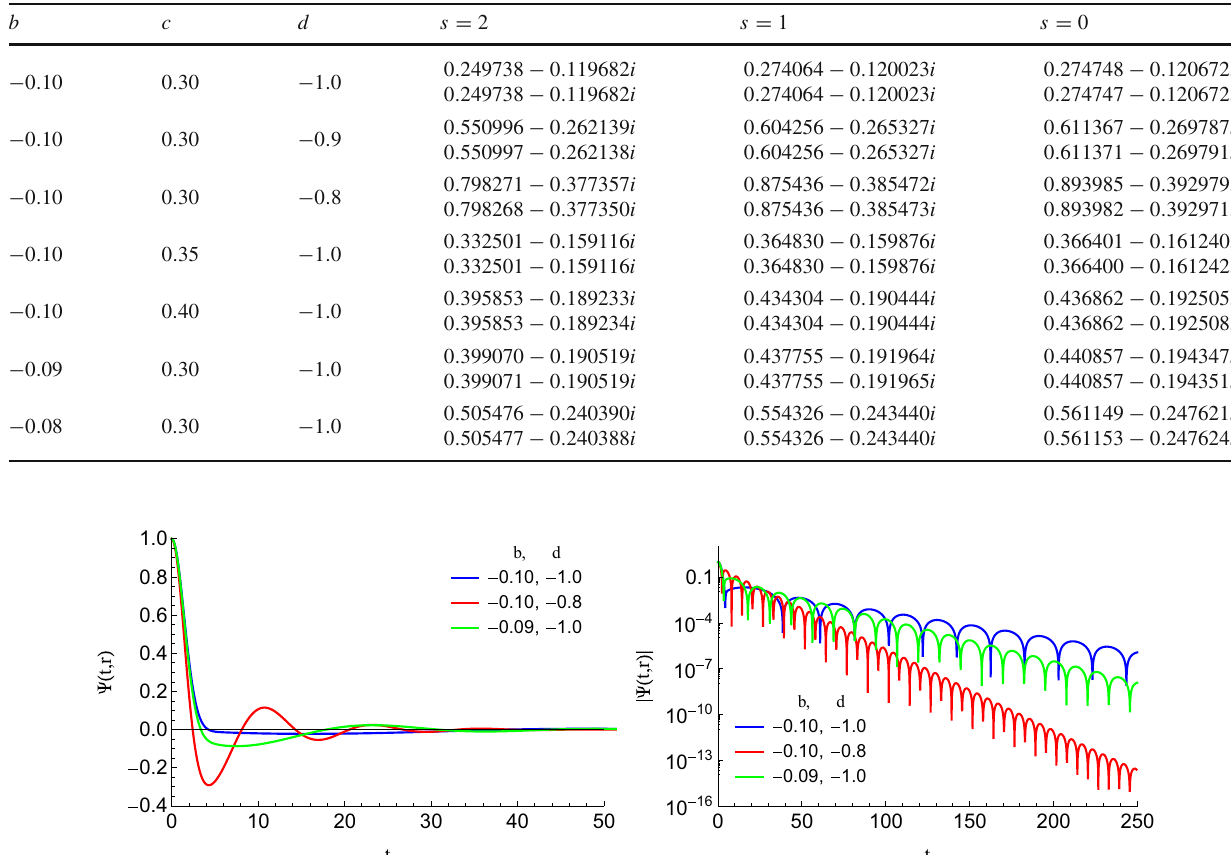
Table 4 The QNMs for n = 1 and (cid:16) = 3, calculated by using the AIM method (first row) and WKB formula (second row)